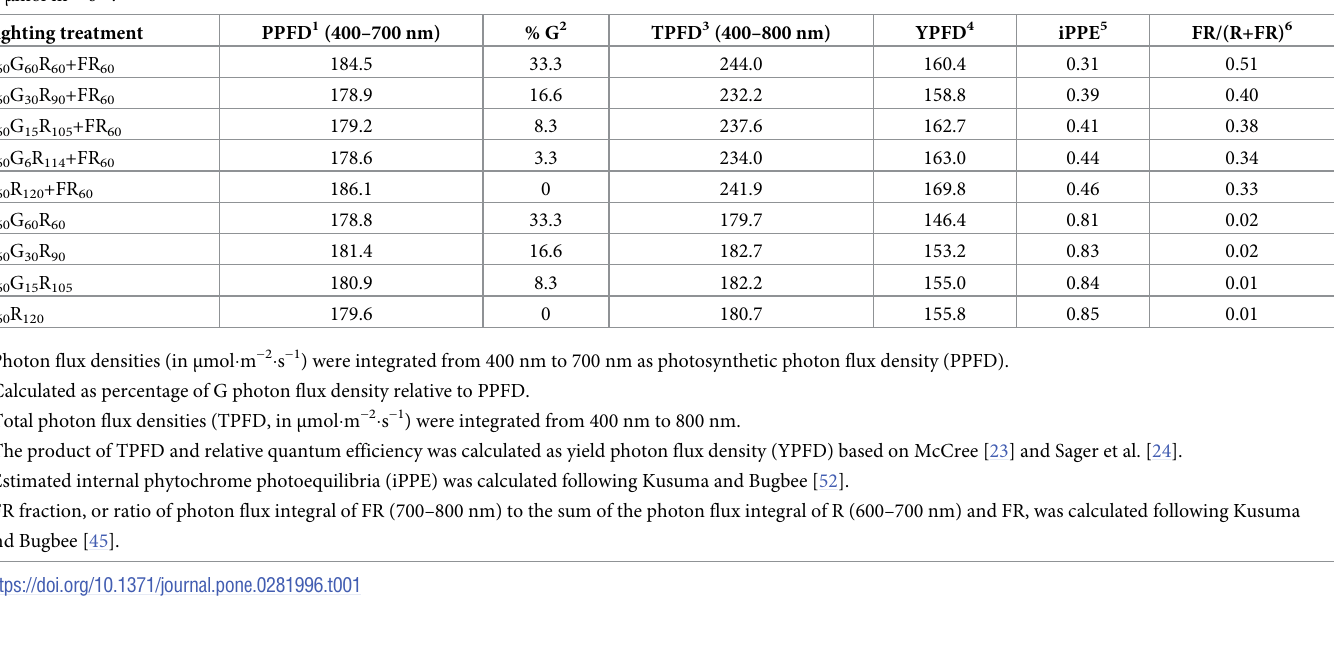
Table 1. Photon flux density and spectral properties of nine lighting treatments. Lighting treatments consisted of blue (B, 400–500 nm), green (G, 500–600 nm), red (R, 600–700 nm), and far-red (FR, 700–800 nm) light delivered by light-emitting diodes. The value that follows each waveband indicates its photon flux density in μ mol � m − 2 � s − 1